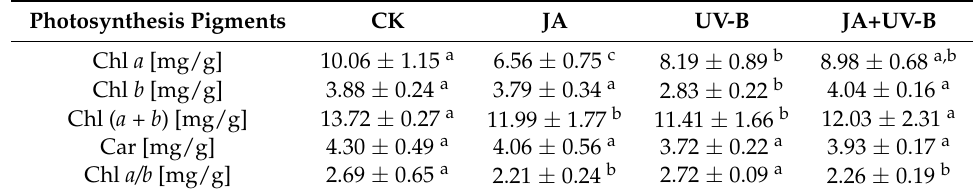
Table 2. JA and UV-B radiation effects on photosynthesis pigments of Scutellaria baicalensis Georgi. chlorophyll a: Chl a , chlorophyll b : Chl b , total chlorophyll: Chl ( a + b ), carotenoid: Car. CK (the control), JA (seedlings were sprayed with 1 mM JA), UV-B (seedlings were treated with 15-d elevated UV-B radiation), JA+UV-B (seedlings were sprayed with 1 mM JA before additional 15-d UV-B radiation). Data are means ± S.E., error bars are means of three replicates. Different lowercase letters are significantly different at p < 0.05 according to Duncan’s multiple range test.